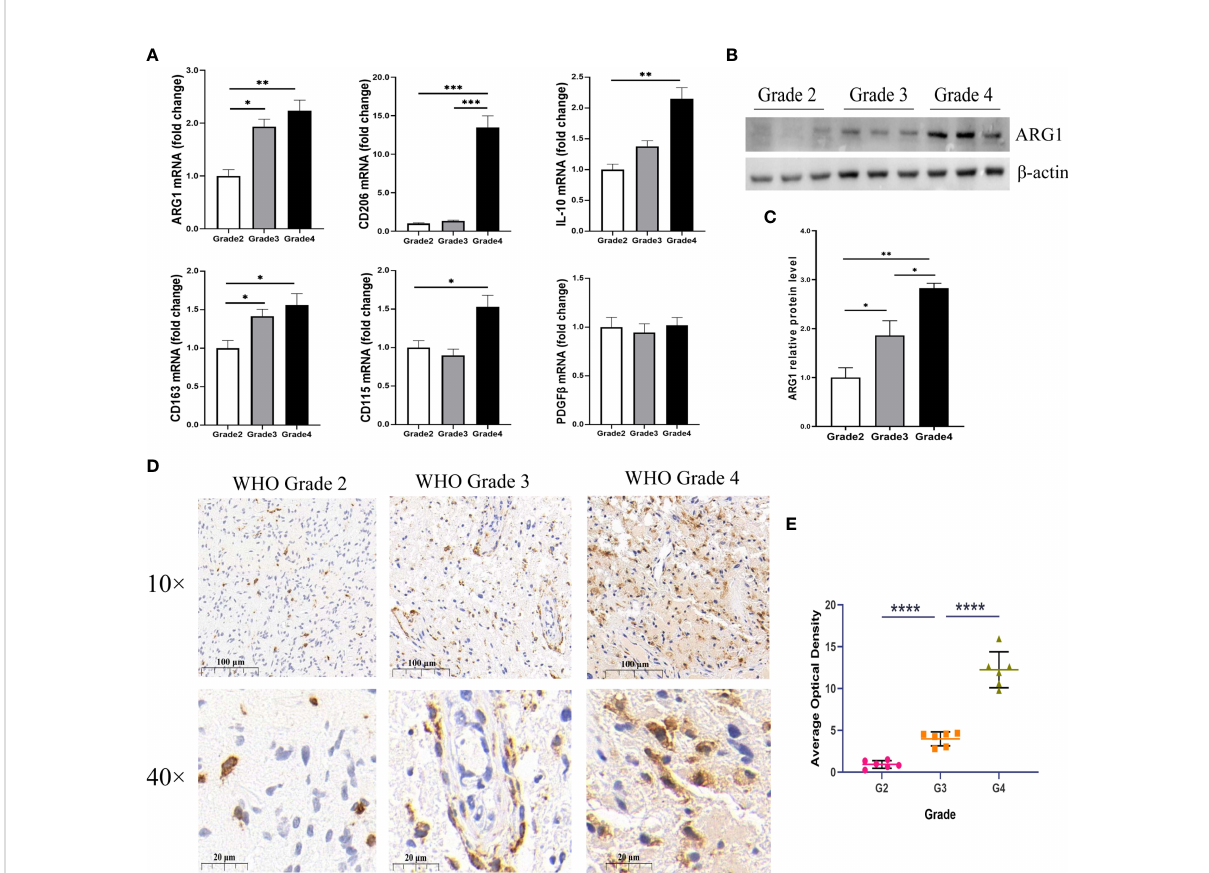
FIGURE 7 Expression of M2 macrophage markers in different WHO pathological grades of glioma. (A) The mRNA expression levels of M2-type macrophage-speci fi c markers, including ARG1, CD206, IL-10, CD163, CD115, and PDGF b in different grades of glioma samples (n = 24). (B) Representative Western blotting images of ARG1 and (C) bar charts of normalized protein expression levels of ARG1 in different grades of gliomas samples (n = 18). (D) Representative images of immunohistochemical (IHC) staining for CD163 in different grades of gliomas (n = 18). (E) Quanti fi cation of CD163 IHC staining in different pathological grades of gliomas (n = 18). *p < 0.05, **p < 0.01, ***p < 0.001, and ****p <